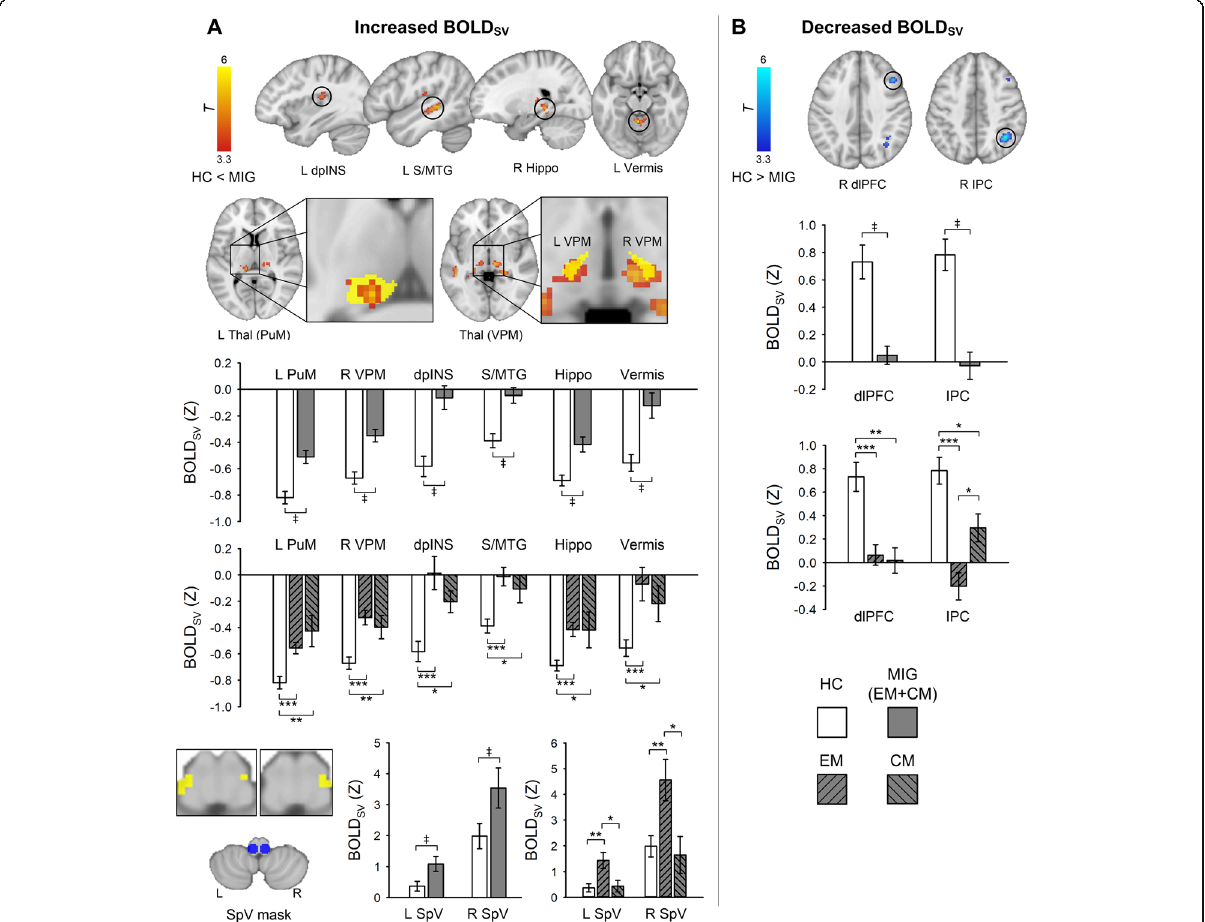
Fig. 1 Group differences of resting-state BOLD signal variability (BOLD SV ) within the frequency of 0.01 – 0.198Hz. a Brain regions displaying increased BOLD SV in MIG patients compared with HCs. Significant thalamic clusters are overlaid on the left PuM, VPM, and right VPM (yellow mask) of the Morel ’ s histology-based atlas for visualization purpose (middle). The left thalamic cluster includes both PuM and VPM. Separate voxel-wise permutation tests were performed for the SpV mask (blue), which was created with 5-mm sphere ROI in the left ( x , y , z : − 6, − 40, − 50) and right ( x , y , z : 6, − 40, − 50) SpV [40]. Significant clusters (yellow) were identified using a threshold-free cluster enhancement ( p < 0.05, FWE- corrected) (bottom). b Brain regions displaying decreased BOLD SV in MIG patients compared with HC. All statistical images are displayed with significant clusters (voxel-level threshold p < 0.001 and cluster-level extent threshold p < 0.05, FWE-corrected). Bar graphs were expressed as mean ± standard error of the mean. Mean BOLD SV (Z) was extracted from a 3-mm sphere around the peak voxel of each significant cluster. Gray squares/bars represent MIG patients ( n = 20), white squares/bars represent HC subjects ( n = 26). MIG patients were divided into EM ( n = 13) or CM ( n = 7) group for further comparison. ‡ p < 0.05 (FWE-corrected). * p < 0.05, ** p < 0.01, and *** p < 0.001 for unpaired t -test. dpINS, dorsal posterior insula; S/MTG, superior and middle temporal gyrus; SpV, spinal trigeminal nucleus; Thal, thalamus; VPM, ventral posteromedial nucleus; PuM, medial pulvinar nucleus; Hippo, hippocampus; dlPFC, dorsolateral prefrontal cortex; IPC, inferior parietal cortex; L, left; R, right; MIG, migraine; HC, healthy control; EM, episodic migraine; CM, chronic